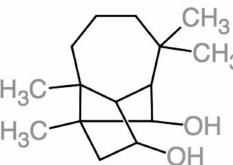
Figure 5. Structure of culmorin. Made on ChemDoodle [77], based on Nara Institute of Science and Technology